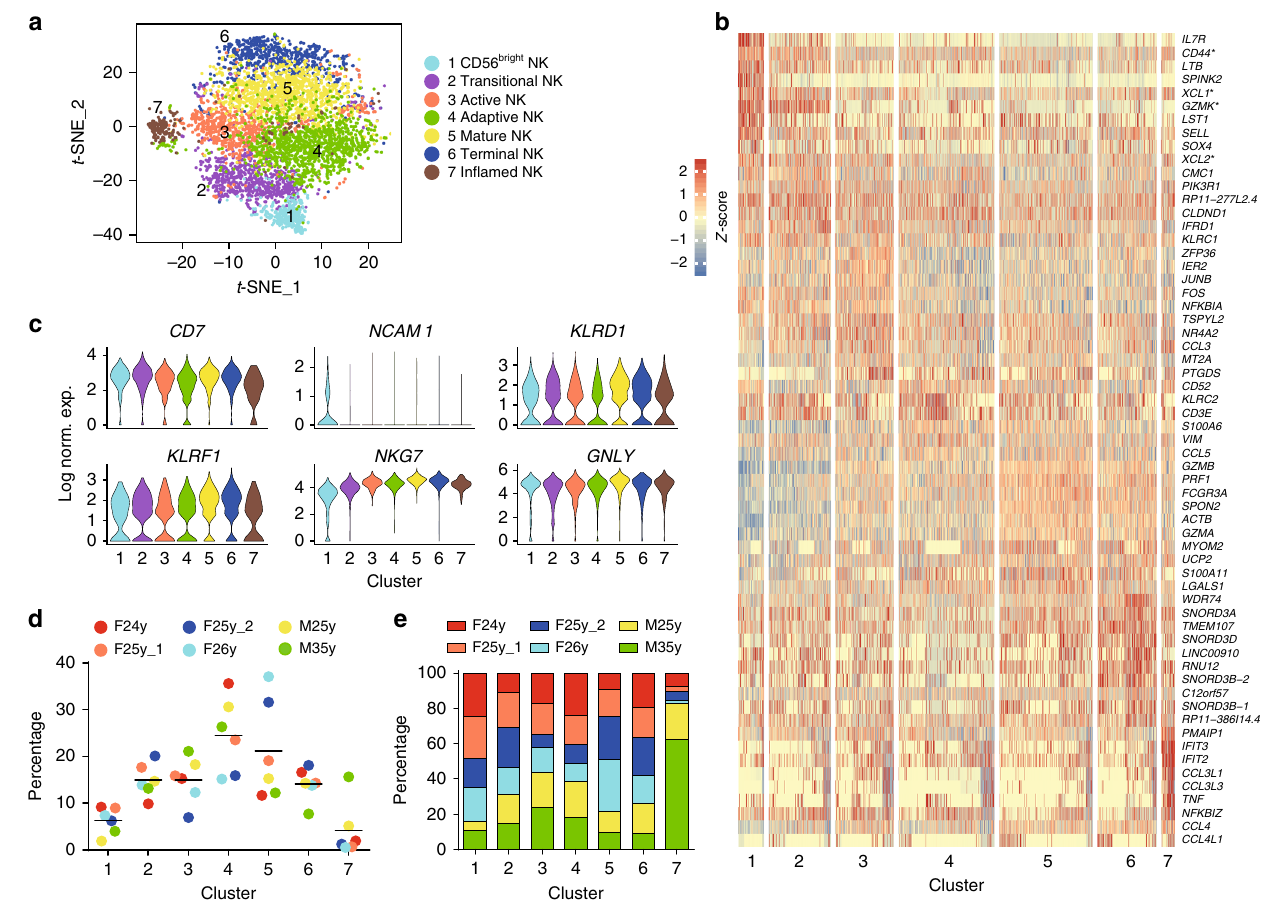
Fig. 1 Unbiased clustering of human NK cells from BM. a Seven distinct human BM NK clusters were numbered, named, and displayed with a t -SNE plot. b Top 10 up-regulated DEGs (ranked by log fold change) of each cluster were plotted using heatmap. * indicates genes that are DEGs of more than one cluster. c Violin plots demonstrate the expression of six NK-lineage-de fi ning markers of each cluster. The y -axis represents log-normalized expression value. d Composition of the clusters within each donor. e Composition of the donors within each cluster. The input cell number from each donor is normalized to be equal. Source data d , e are provided as a Source Data fi le. See also Supplementary Figs. 1, 2, 3, and